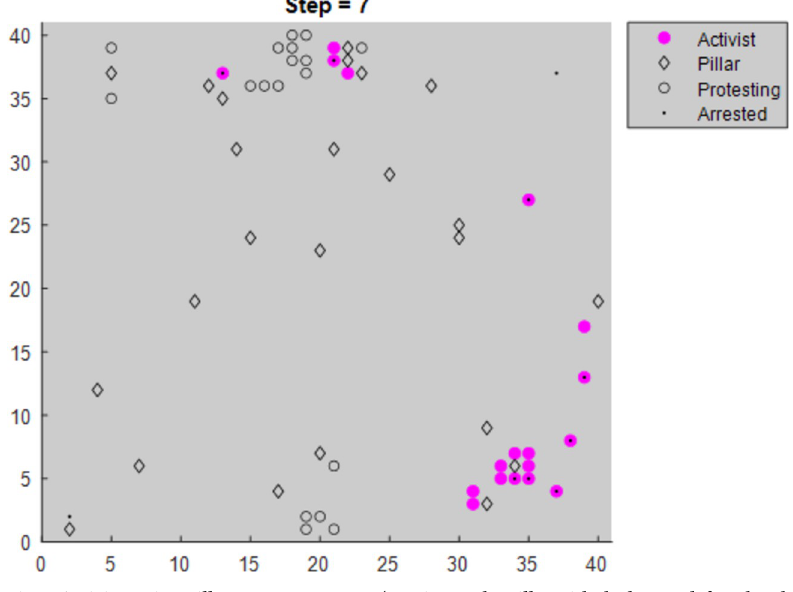
Fig 7. Activists using Pillar Prox strategy = 2 (Moving to the pillar with the lowest defect threshold).